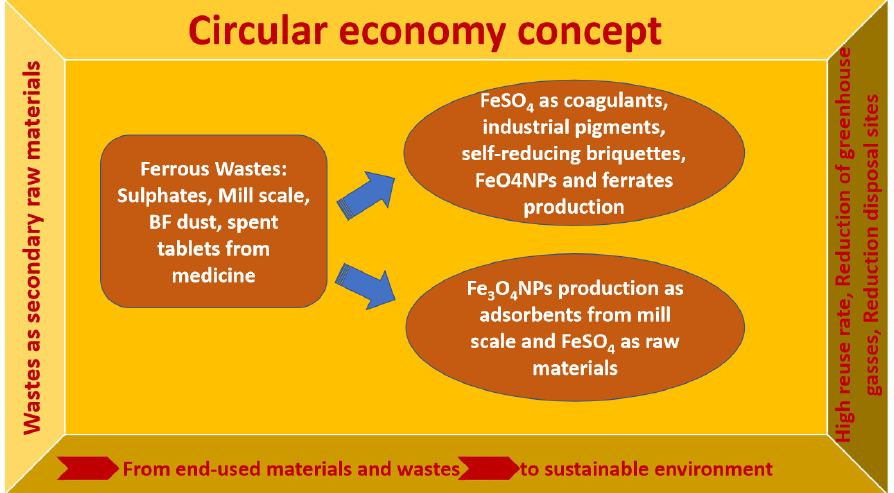
Figure 1. Valorization alternatives for ferrous wastes under the circular economy